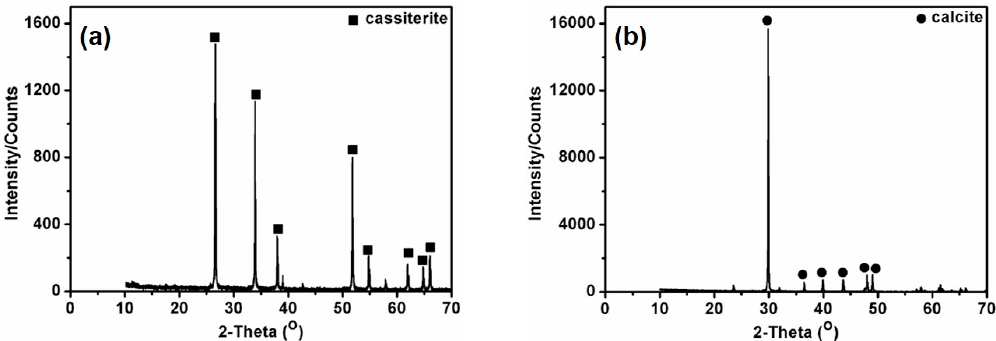
Figure 1. XRD spectrum of cassiterite ( a ) and calcite ( b ) minerals.